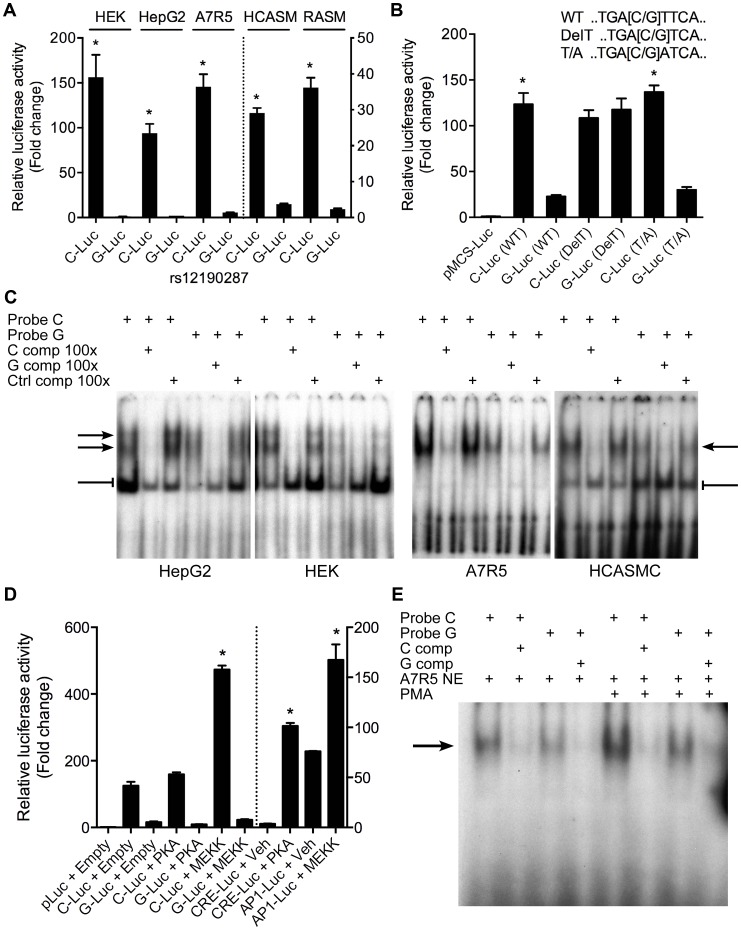
Allele-specific transcriptional activity at rs12190287.(a) Transcriptional activity of rs12190287-C and G variants were determined in heterozygous primary human coronary artery smooth muscle (HCASM), rat aortic smooth muscle cells (RASM) and HEK, HepG2, and A7r5 cell lines. pLuc-MCS vector containing the putative enhancer region for each rs12190287 variant (C-Luc and G-Luc) was transfected for 24 hours and the ratio of firefly and Renilla luciferase activities were normalized to empty reporter (pLuc). *P<0.01 versus G-Luc for each condition. (b) Dual-luciferase assay of wildtype rs12190287 enhancer or mutants, DelT or T/A (as shown), transfected in A7r5 as described above. *P<0.001 versus G-Luc for each condition. (c) Electrophoretic mobility shift assays (EMSA) showing protein binding to [γ32P]ATP-labeled rs12190287 C/G probes incubated with nuclear extract (NE) from various cell types, along with 100× excess C, G, or negative control (C, G, or Ctrl comp) unlabeled probe as competitor. Arrows and bar-headed lines represent specific and non-specific shifted complexes, respectively. (d) Dual-luciferase assay of rs12190287 C/G enhancer co-transfected with empty vector (Empty) or constitutively active protein kinase A (PKA) or mitogen-activated protein kinase (MEKK) in A7r5 using consensus CRE and AP-1 reporters as positive controls. *P<0.001 versus C-Luc+Empty or CRE-Luc+Veh or AP1-Luc+Veh where indicated. (e) EMSA of rs12190287 C/G with respective competition showing protein binding using control A7r5 or PMA treated A7r5 NE. Values are mean ± SD from triplicates. Similar results were observed from three independent experiments.